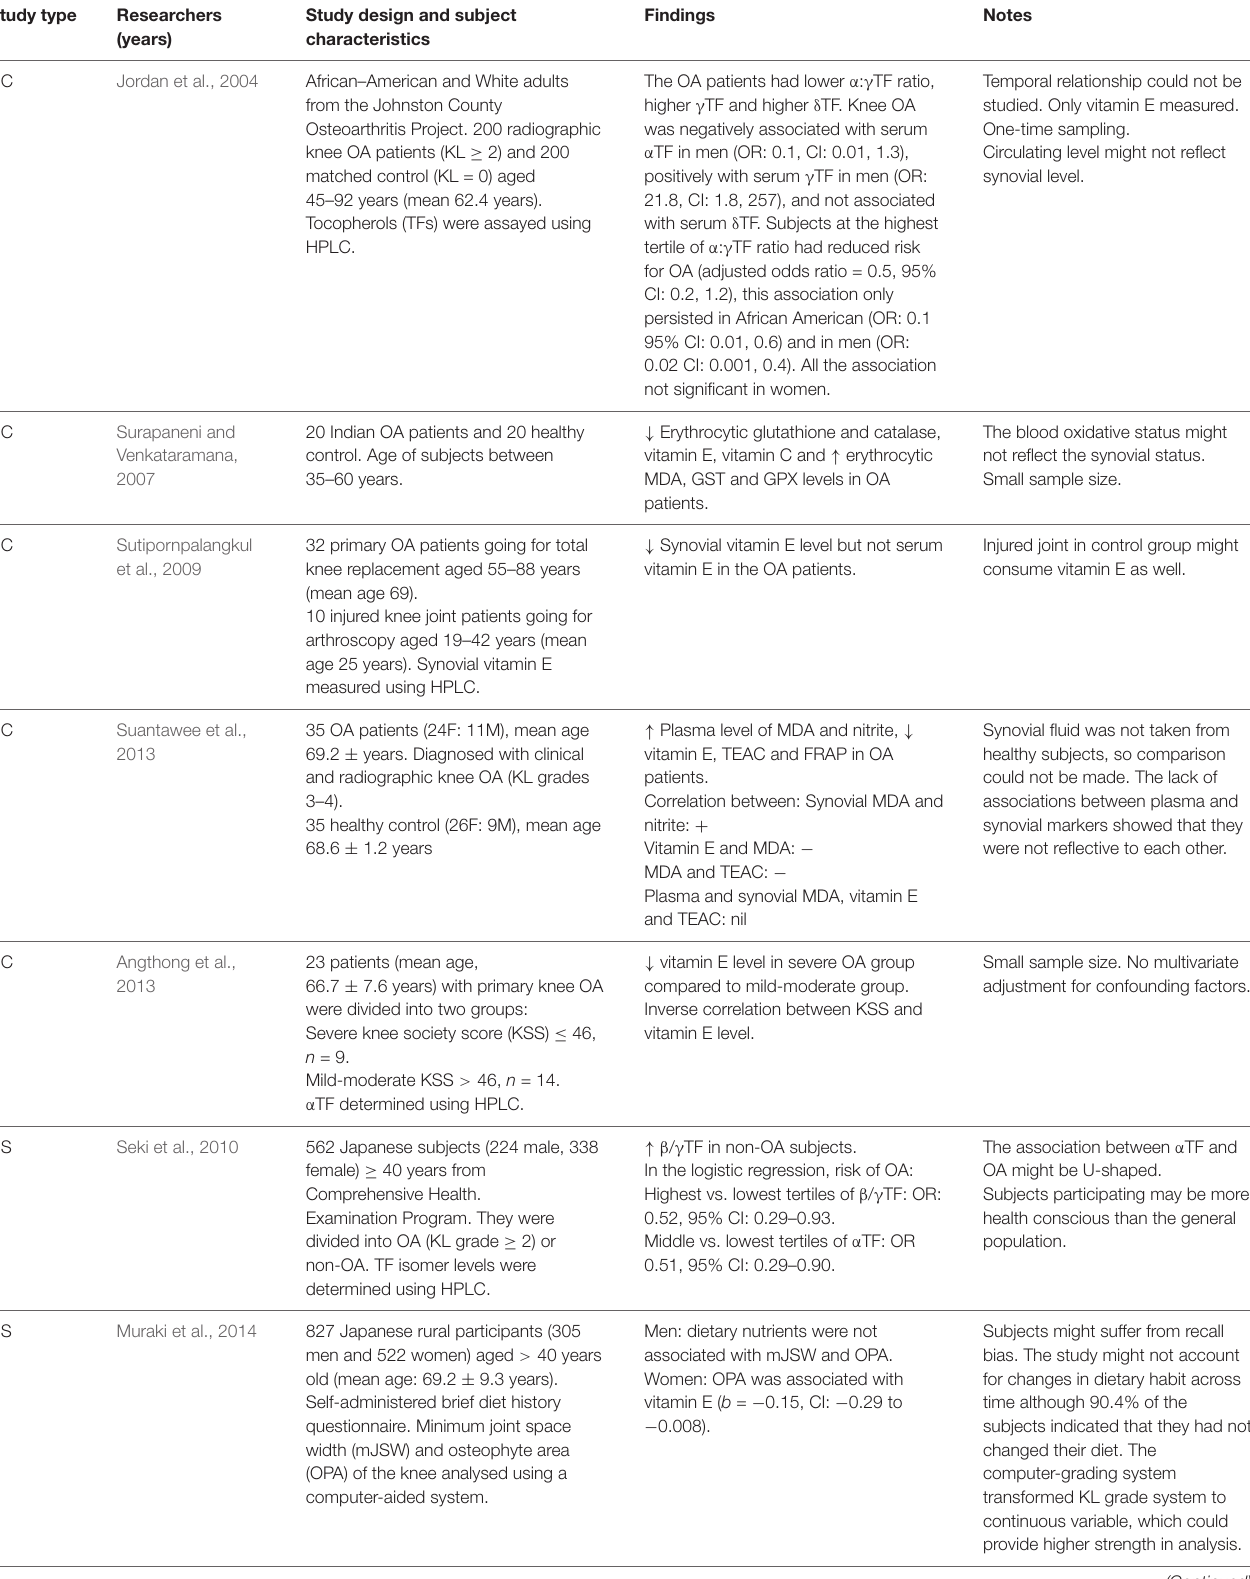
TABLE 1 | Positive relationship between vitamin E and joint